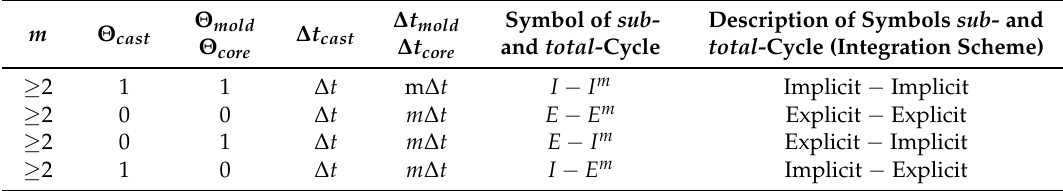
Table 1. The combination of applied integration schemes. ( m is a numerical stability coefficient, Θ is a parameter of one-step time integration scheme—assumes value 0 or 1 in the examined case, I is a symbol indicating the implicit scheme, and E a symbol indicating the explicit